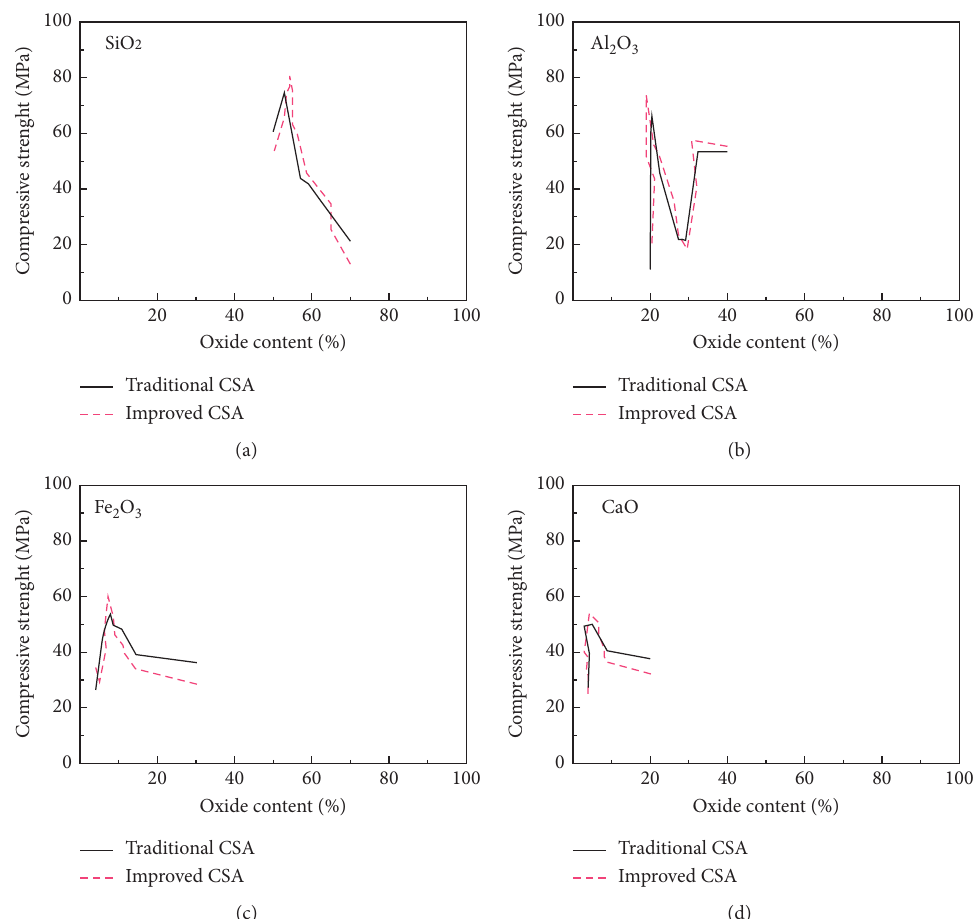
Figure 4: Variation of 28d compressive strength with different oxide proportion. (a) Compressive strength vs. SiO strength vs. Al 2 O 3 . (c) Compressive strength vs. Fe 2 O 3 . (d) Compressive strength vs.